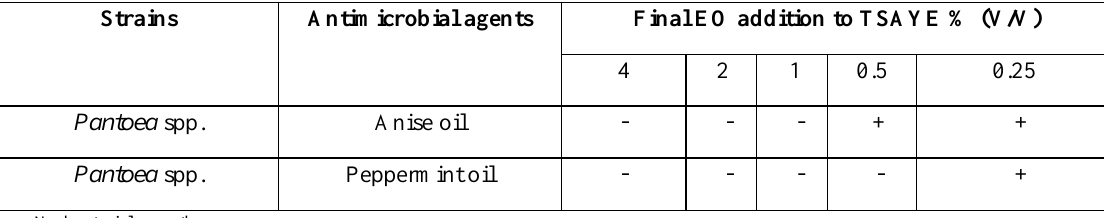
Table 3. Determination of minimum inhibitory concentration (MIC) of anise oil and peppermint oil against Pantoea spp. isolates.